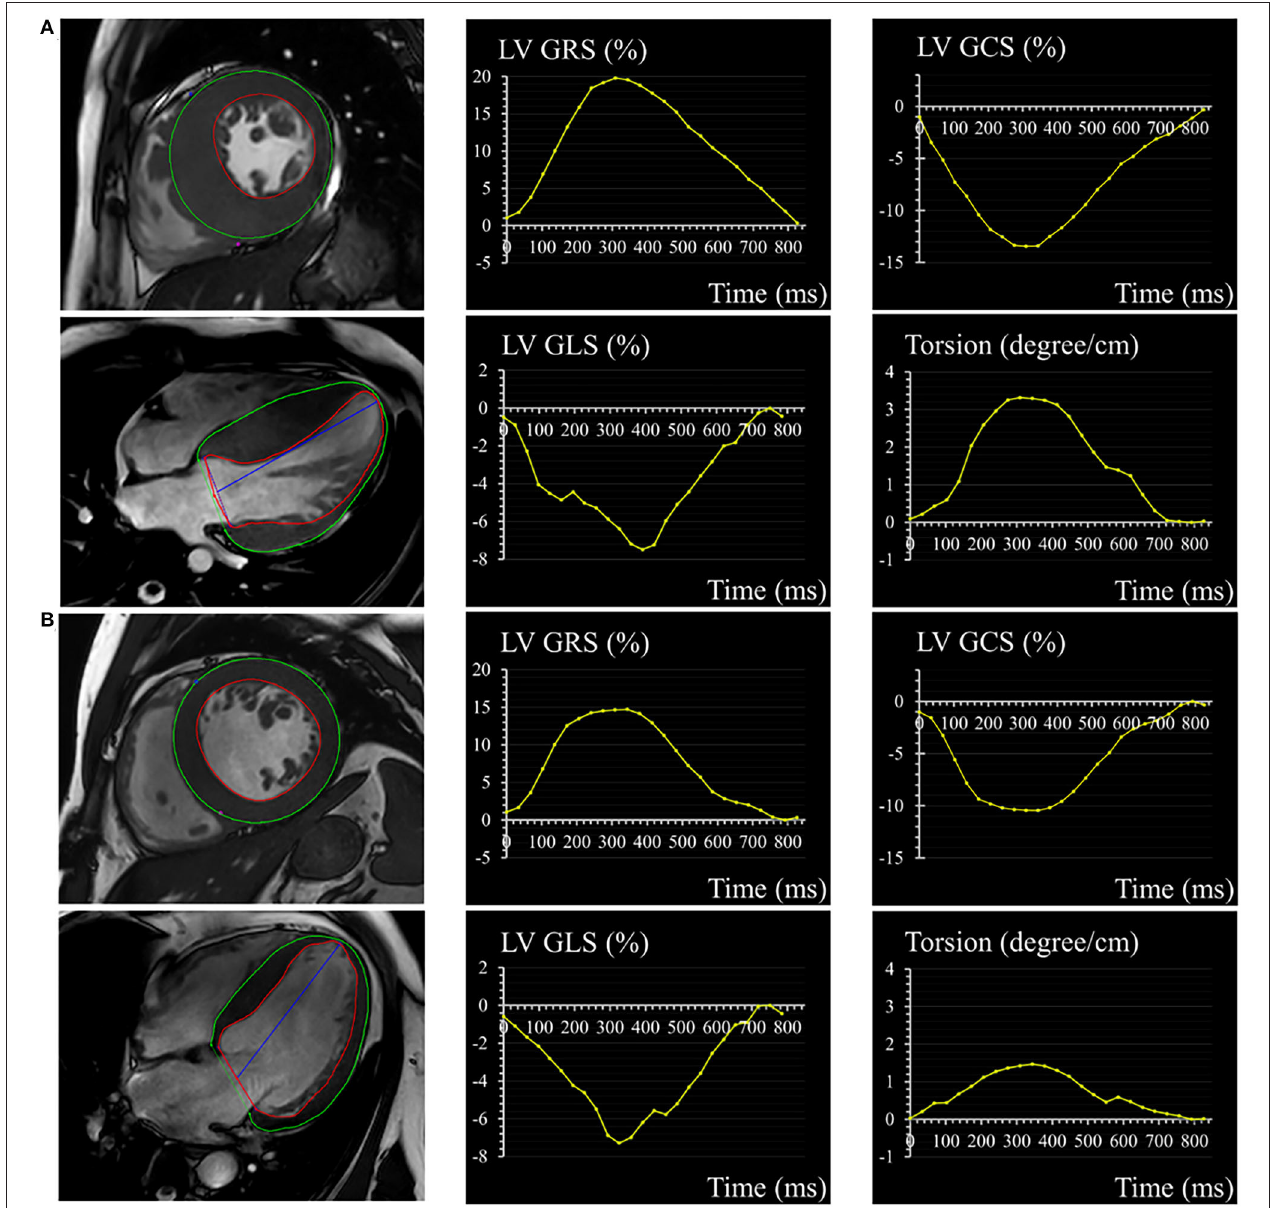
FIGURE 1 | A 32-year-old male with HCM (A) and a 56-year-old male with HHD (B) . Epicardial (green) and endocardial (red) contours, as well as the corresponding curves of LV GRS, GCS, GLS, and torsion in HCM and HHD. HCM, hypertrophic cardiomyopathy; HHD, hypertensive heart disease; LV, left ventricular; GRS, global radial strain; GCS, global circumferential strain; GLS, global longitudinal strain.